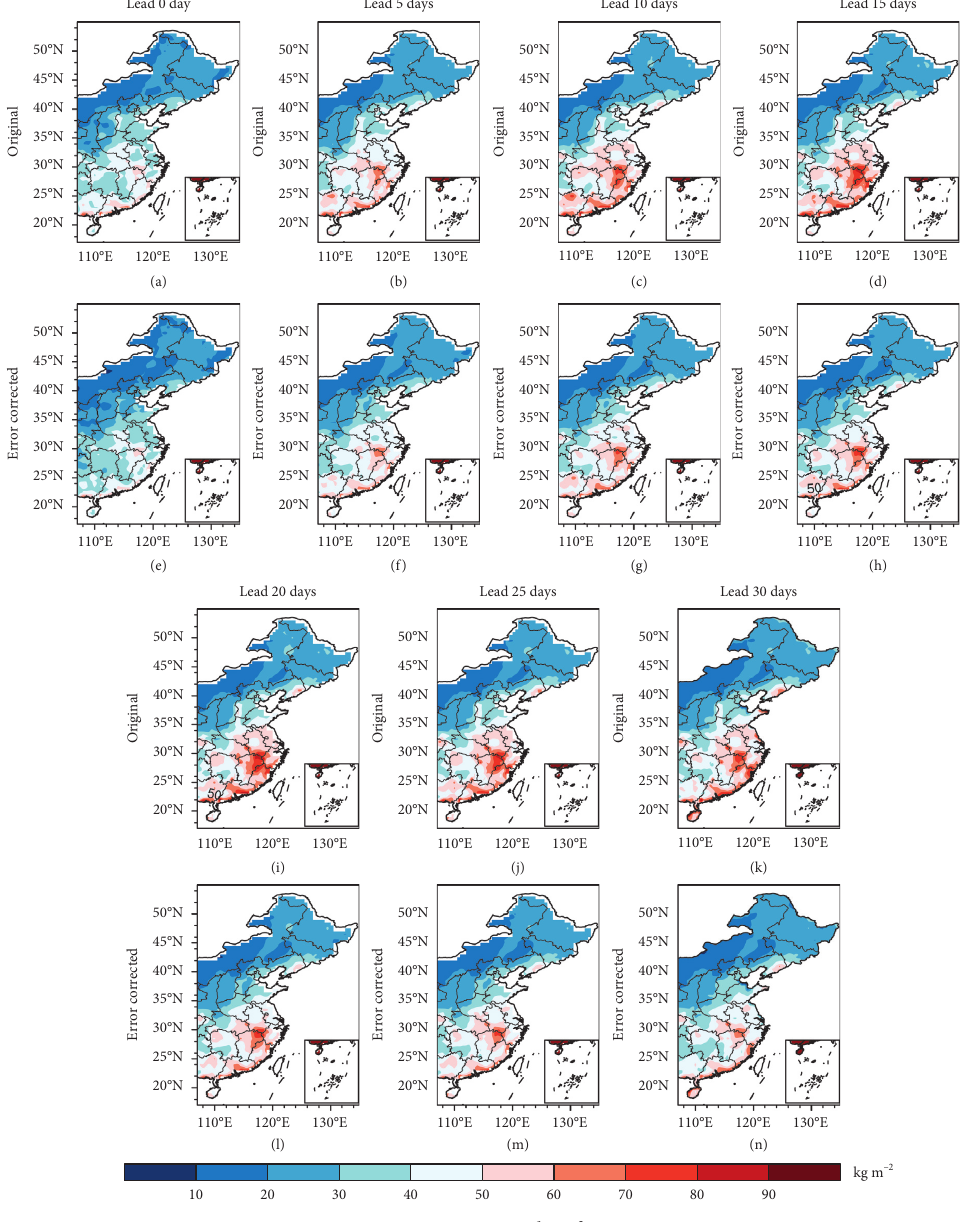
Figure 6: As in Figure 5, but for